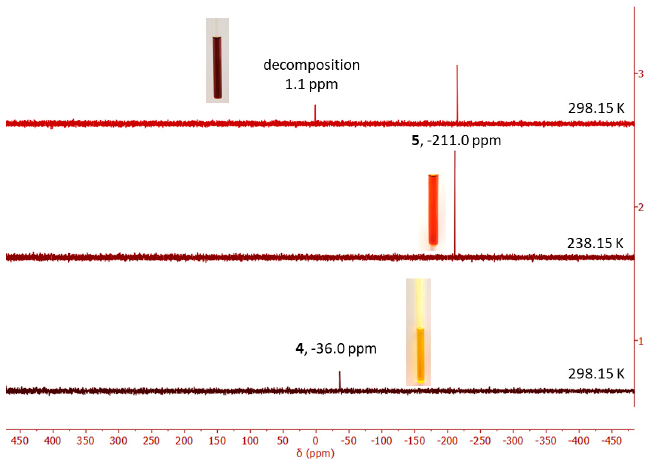
Figure 5. 119 Sn{ 1 H} NMRs of stannole 4 stannolate 5 , and the decomposition. After ~1 min at 298.15 K, the solution turned dark brown and was turbid brownish-yellow with